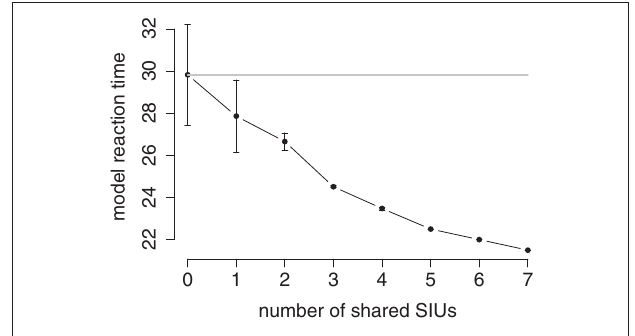
Figure 3 | Model reaction time for a familiarity decision in a double- familiarity task as a function of shared features between the two presented names. The plot shows the mean value and SD over 20 different random networks. The gray line marks the control condition